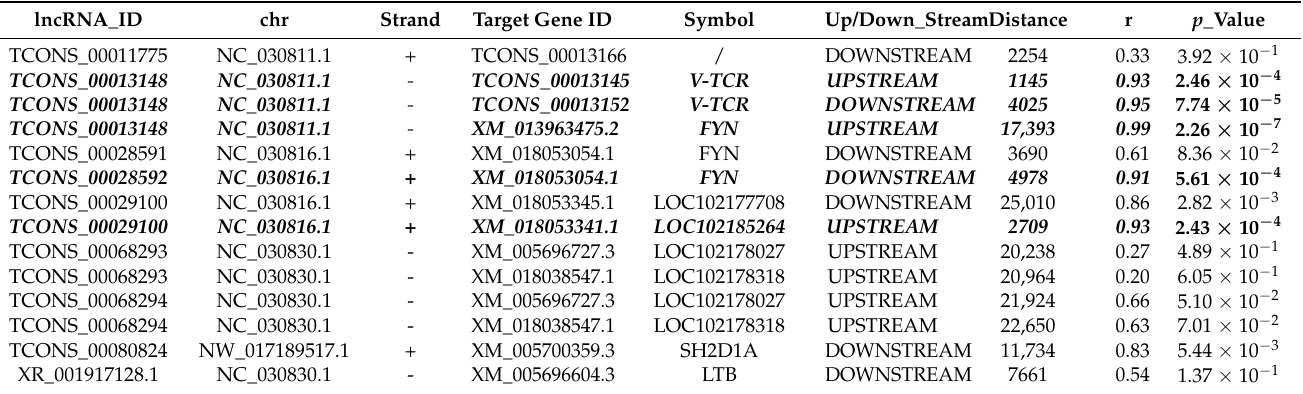
Table 6. Analysis of lncRNAs and cis-regulated target mRNAs in the first four significantly enriched